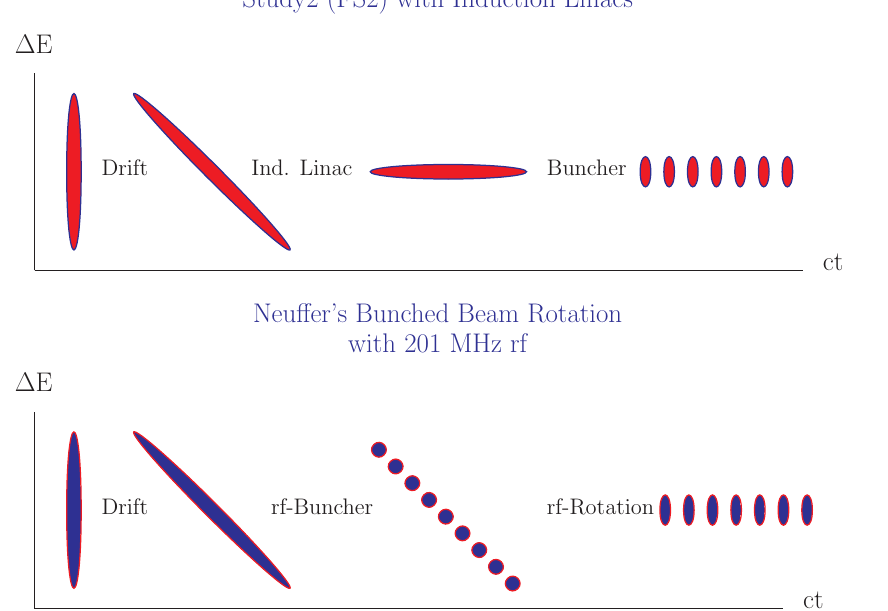
FIG. 2. (Color) Comparison of the buncher concept used here (bottom) with the bunching system used in FS2